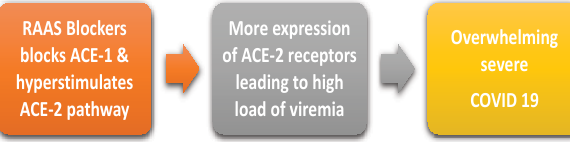
Figure 4: Deleterious Eff ect of RAAS blockers on COVID 19.